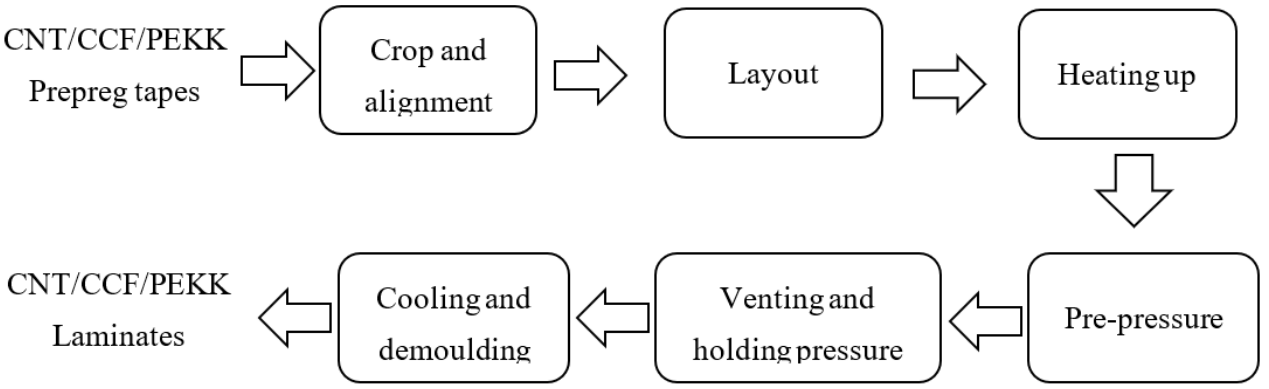
Figure 2. Preparation flowchart of CNT/CCF/PEKK laminate.